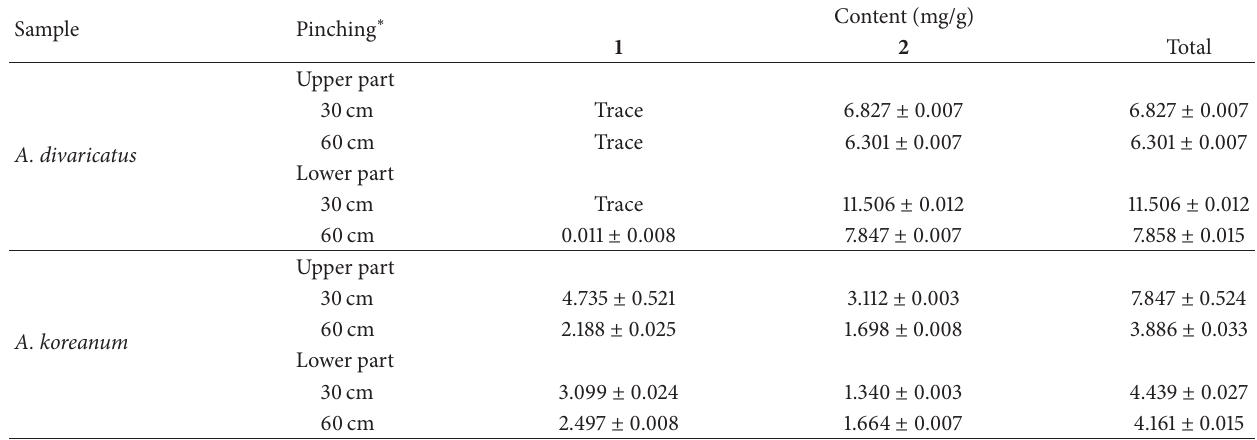
Table 2: The contents of eleutherosides B ( 1 ) and E ( 2 ) in A. divaricatus and A. koreanum cultivated by different pinching sites.